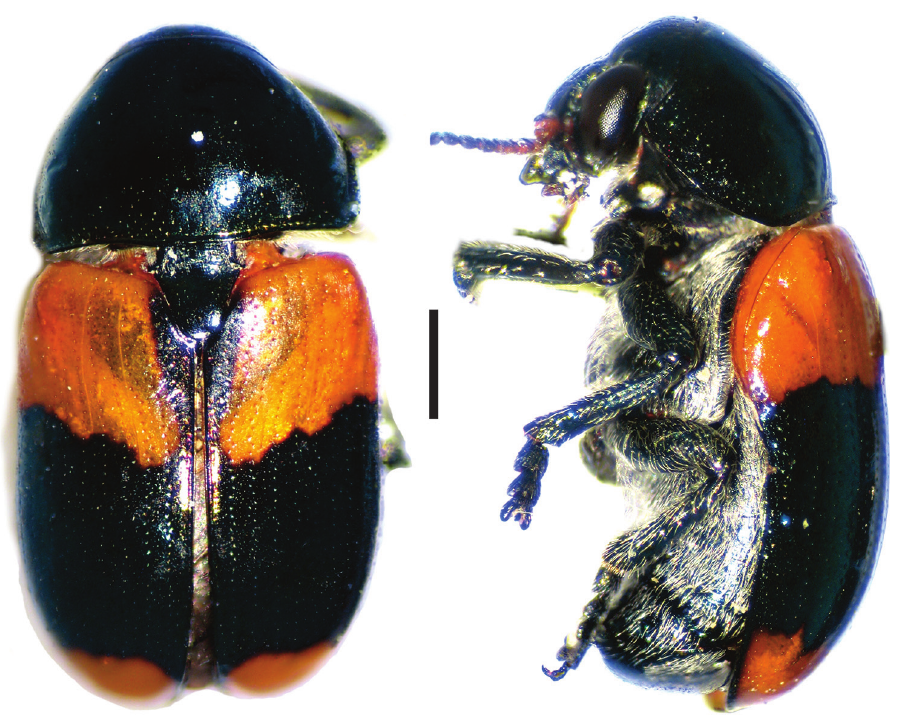
Figure 5. Babia ( Coleolacordairei ) elongata Guérin (1) , left: habitus (dorsal view), right: habitus (lateral Note. Moldenke (1981), divided Babia into six subgenera based on morphological fea- tures, such as the general shape of the body, pronotal margin, frons and antennomere morphology: Babia ( Babia ) Chevrolat and B. ( Archaebabia ) Moldenke from America north of Mexico; Babia ( Coleolacordairei ) Moldenke, Babia ( Heterobabia ) Moldenke, and Babia ( Megababia ) Moldenke from the Neotropical region. Only the monotypic B. ( Coleolacordairei ) is represented in Argentina.